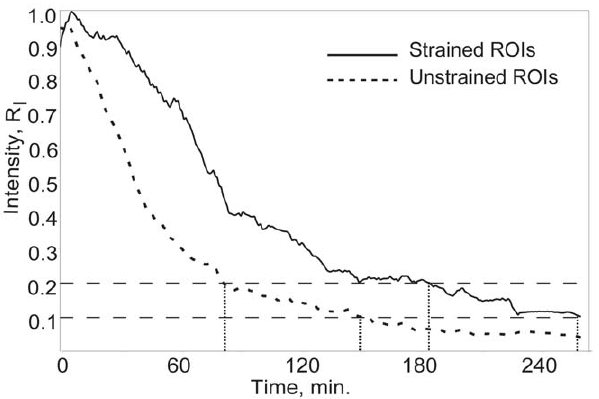
Figure 3. Normalized edge intensity vs. time (minutes) for loaded (solid line) and unloaded (dashed line) ROIs shown in fig. 5. Typically, the noise threshold of the edge intensity algorithm is somewhere between R I [0.1, 0.2]. Note the large differences in degradation time between loaded and unloaded ROIs when R I =0.1 or R I =0.2 are used as end points (110 or 120 min. respectively).